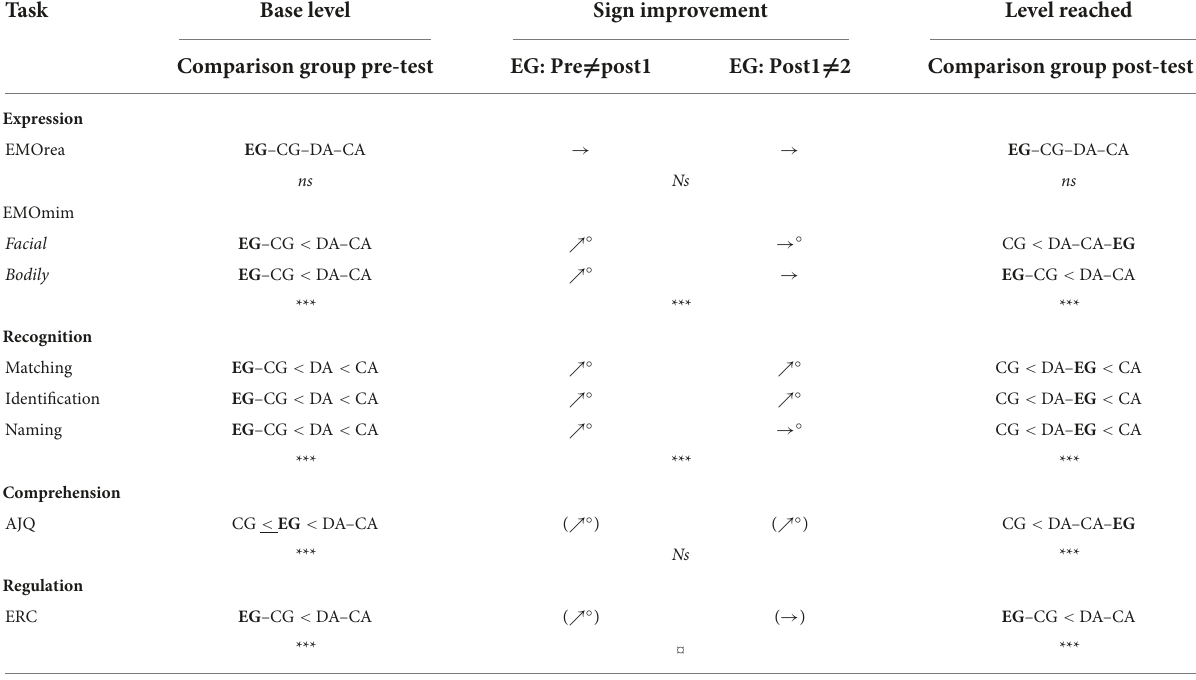
TABLE 2 Summary of results of the three steps of analyses for each task. Task Base level Sign improvement Level reached Comparison group pre-test EG: Post1 (cid:54)=